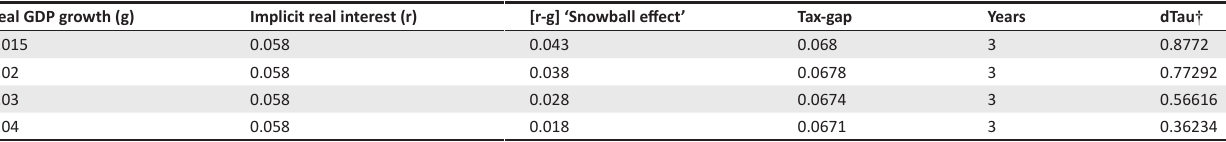
TABLE 3: Cost of postponing fiscal consolidation. Real GDP growth (g) Implicit real interest